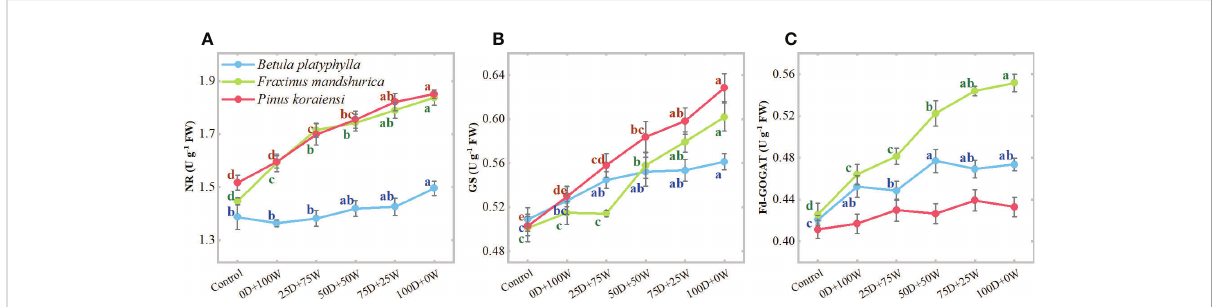
FIGURE 3 Activities (U g -1 FW, A-C ) of nitrate reductase (NR), glutamine synthetase (GS) and glutamate synthase (Fd-GOGAT) in leaves of three species affected by six canopy nitrogen (N) application treatments for 32 days. N application treatments included a control (no application of N) and fi ve types of N deposition with dry to wet ratios of 0:100 (0D+100W), 25:75 (25D+75W), 50:50 (50D+50W), 75:25 (75D+25W) and 100:0 (100D+0W), respectively. Error bars indicate the standard error of the mean ( n = 5). Within the same species in each panel, different letters on the left side of the error bar demonstrate signi fi cant differences among six treatments ( P < 0.05) according to the least signi fi cant difference test. The scales of the y -axis are different in each panel.